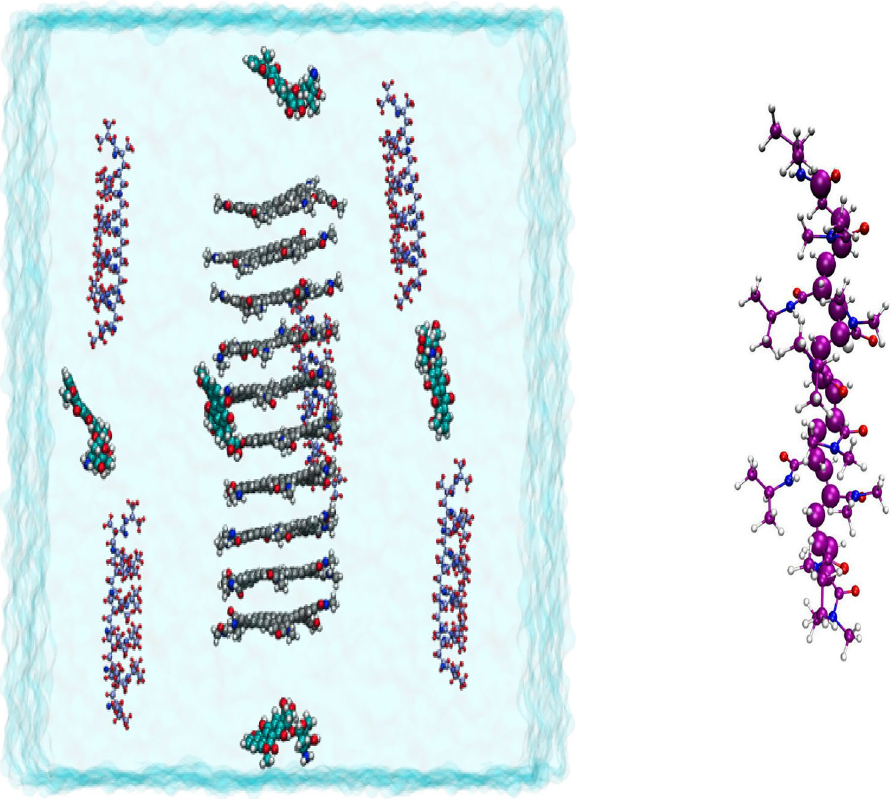
Figure 1. Left: The initial snapshots of DOX–Polymer–Hexakis systems. Color code DOX: vdW cyan, Polymer: CPK violet, Hexakis: silver. The ions molecules are not shown for clarity. Right: Snapshot of DMA polymer chains for 10-mer (backbone carbon atoms of CH2 are shown in violet).